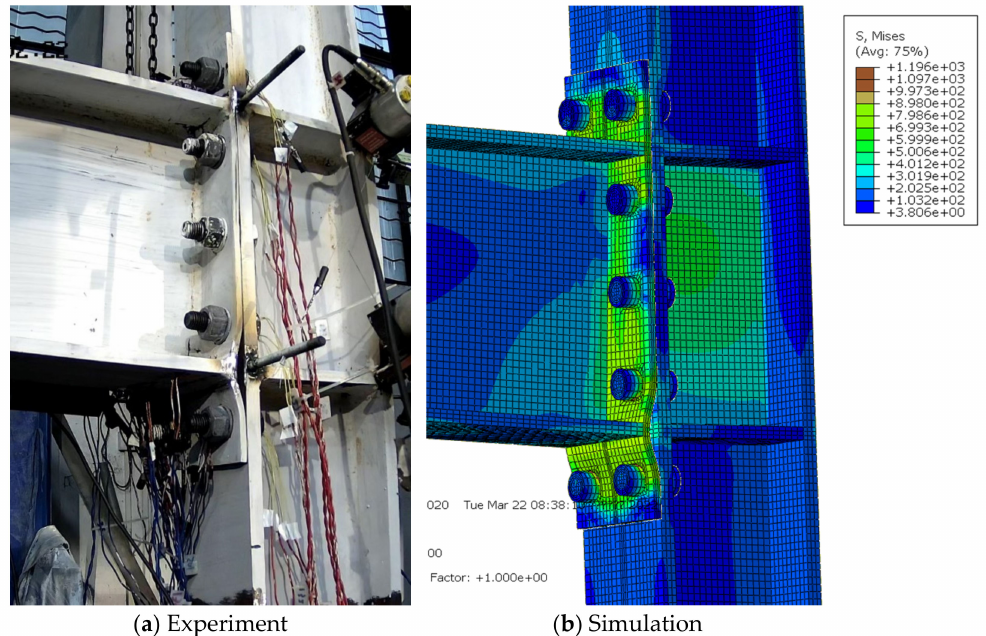
Figure 8. Comparison of experimental and simulated deformation modes in specimen S3 at the second negative peak of 4% loading stage.